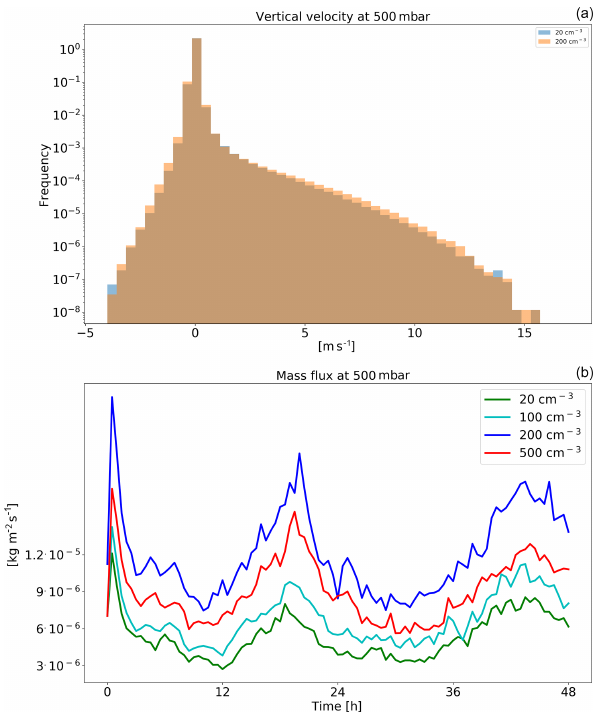
Figure 19. Histograms of ICON-simulated vertical velocity at the level of 500mbar for clean (CDNC = 20cm − 3 ) and polluted (CDNC = 200cm − 3 ) simulations (a) , and the time evolution of the net upwards water (liquid and ice) mass flux (b) for the different CDNC simulations for the deep-cloud-dominated case (16–18 Au- gust 2016). The 500mbar level is chosen, as it represents the tran- sition between the warm part to the cold part of the clouds. In the histogram only two simulations are presented for